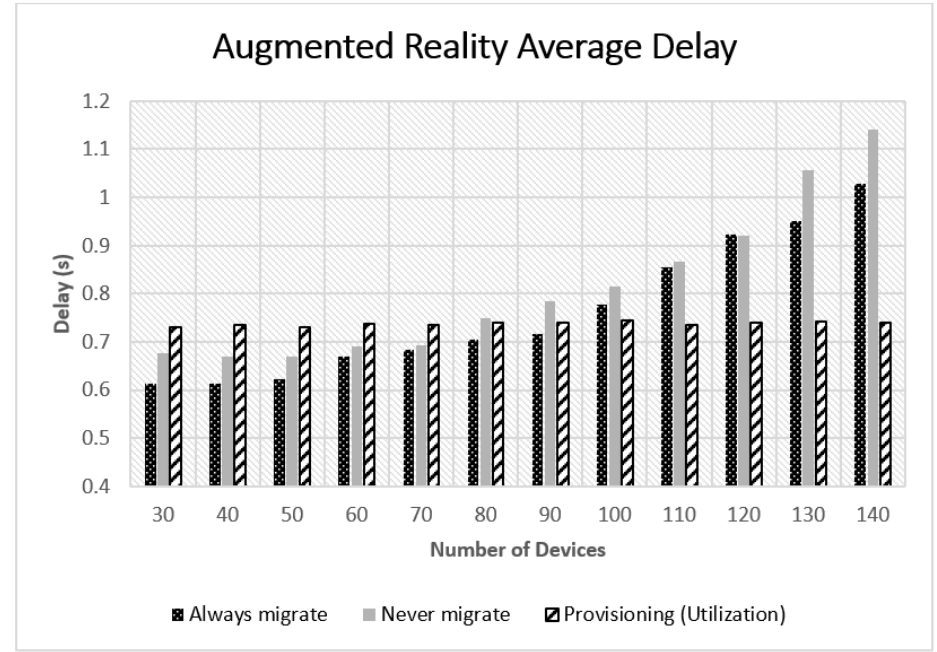
Figure 4. Augmented reality average E2E delay for different